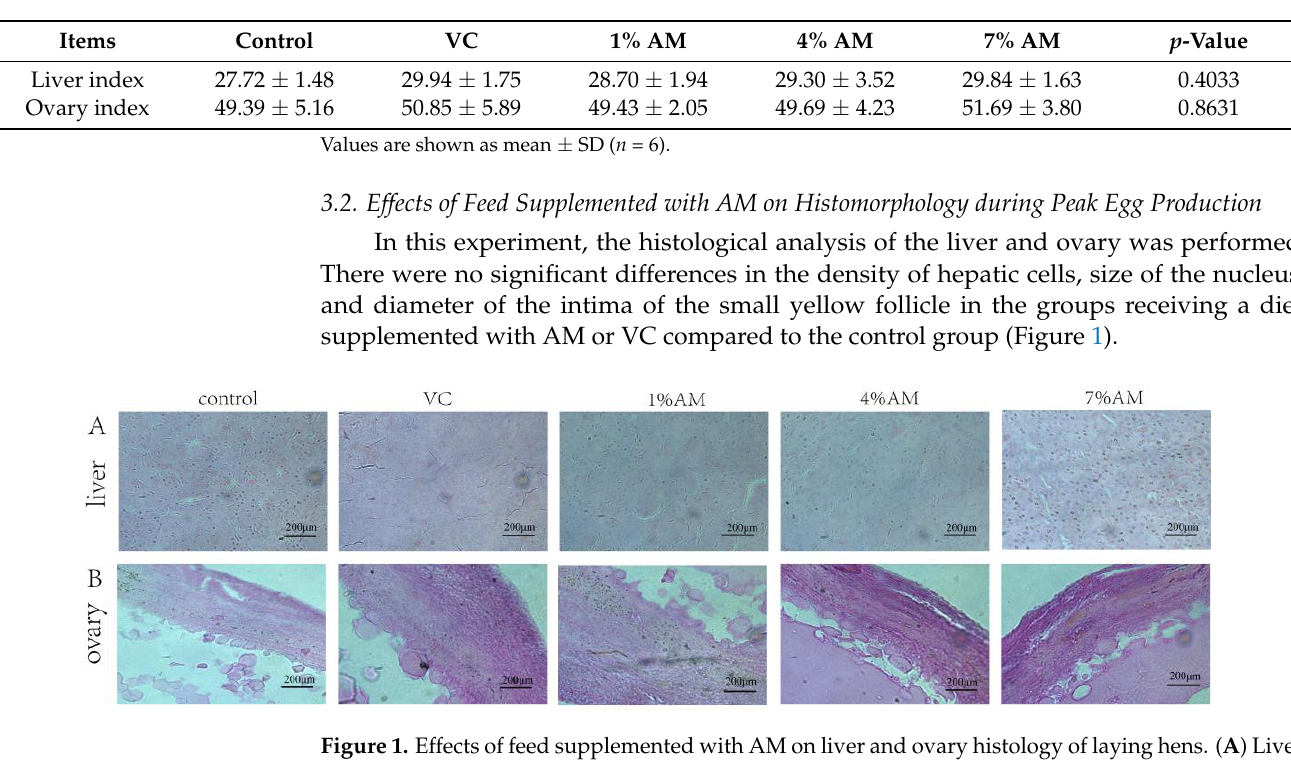
Table 1. Effects of feed supplemented with AM on organ index of laying hens.